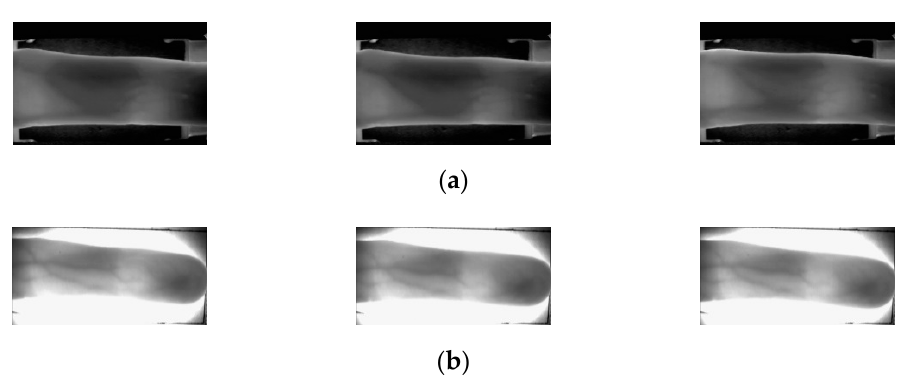
Figure 8. Images obtained from the same finger. ( a ) SDU-DB and ( b ) PolyU-DB.